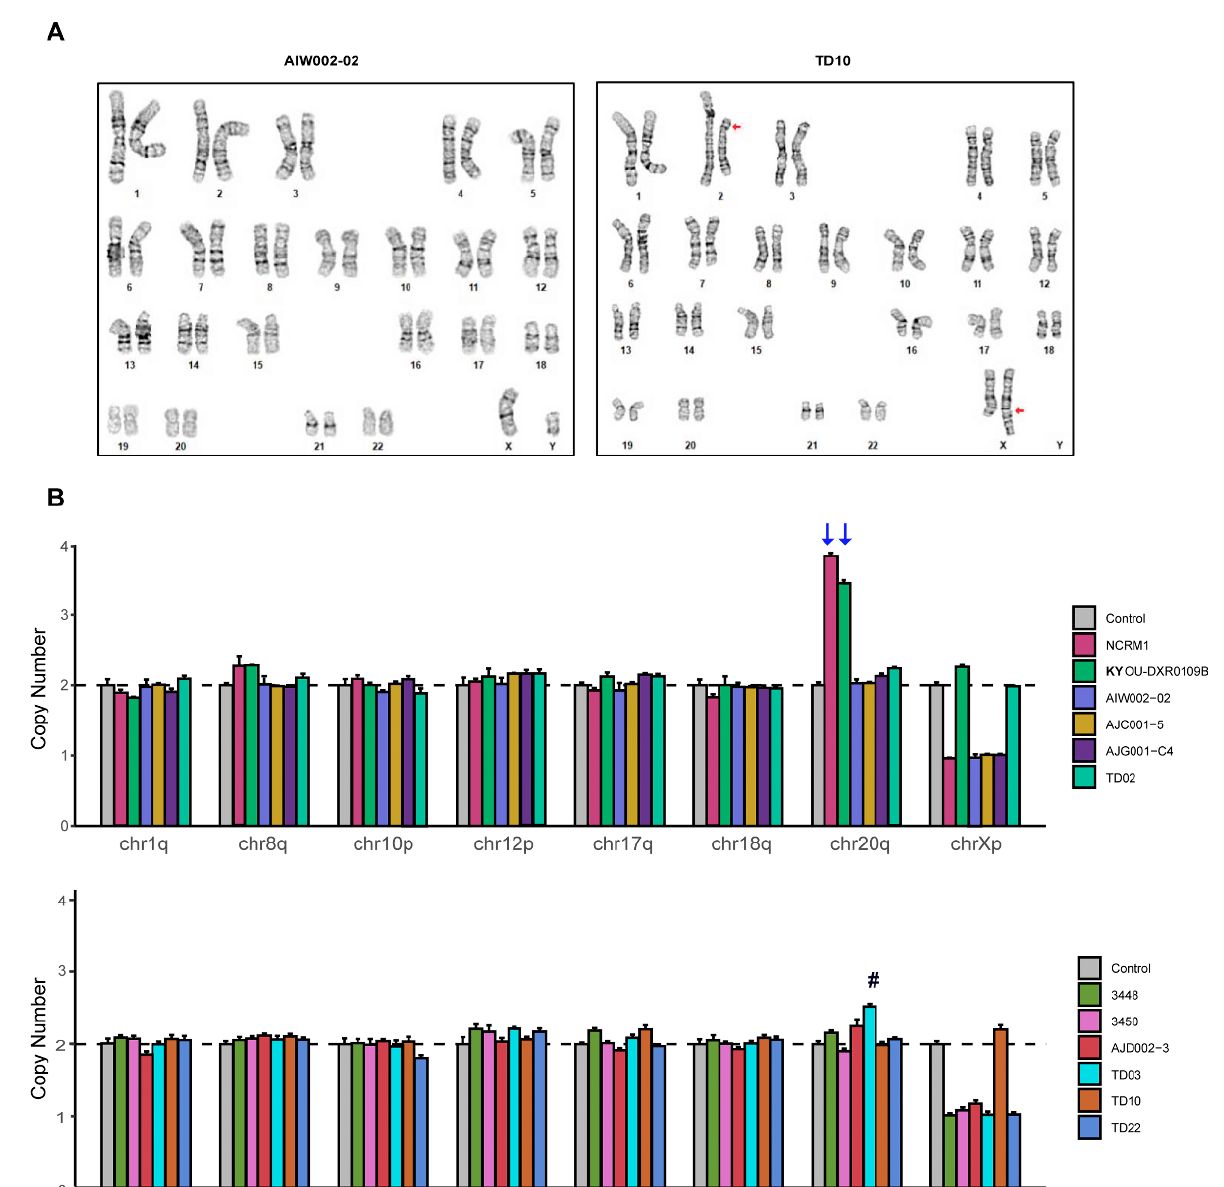
Figure 4. Genomic integrity analysis of hiPSCs. ( A ) Karyotyping and G-band analyses showing examples of one normal (left) and one abnormal hiPSC karyotype (right). An apparently balanced translocation between the long (q) arm of chromosome X and the short (p) arm of chromosome 2 is present in TD10 (red arrow). ( B ) qPCR-based genetic analysis to detect small chromosome abnormalities in all hiPSC lines. The copy numbers of chr1q, chr8q, chr10p, chr12p, chr17q, chr18q, chr20q, and chrXp were normalized to chr4p expression set at 2. Error bars show standard deviation from technical triplicates from two independent experiments. There are no abnormalities within critical regions in our cell lines, while NCRM1 and KYOU-DXR0109 have amplification of chr20q (indicated by blue arrows). TD03 shows a slight increase in chr20q (indicated with #), however this is not above the threshold of expected variation.